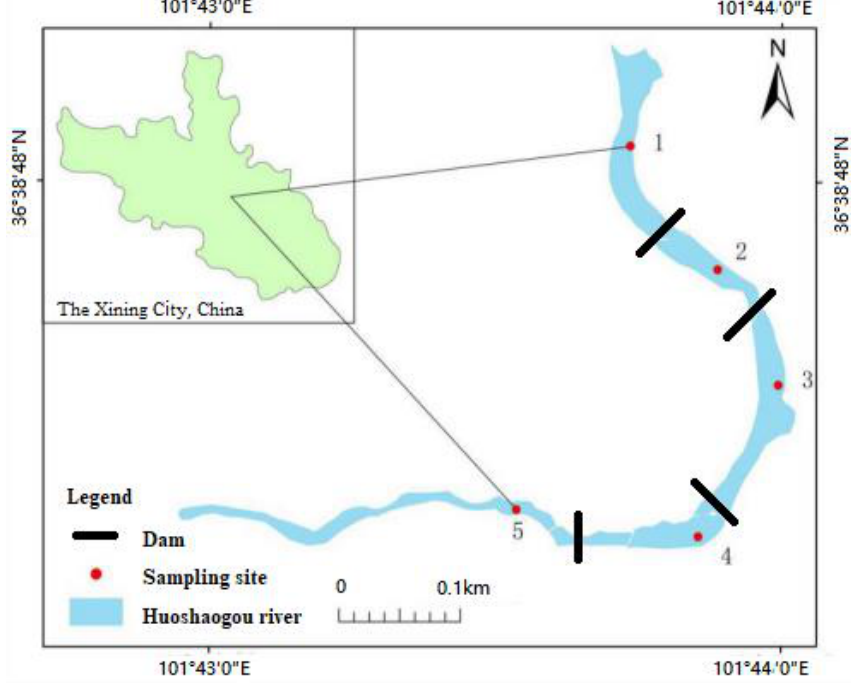
Figure 1. Location of the Huoshaogou River in the Qinghai Province, China.